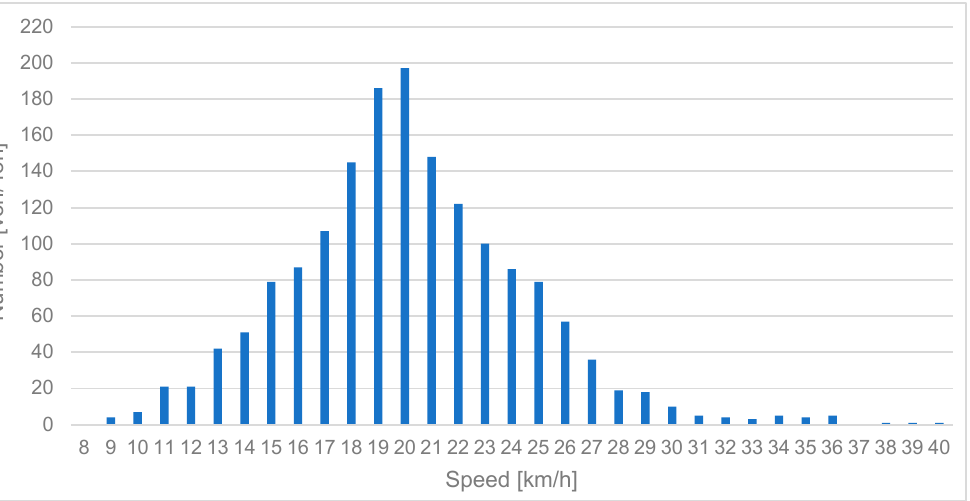
Figure 10. Comparison of the number of vehicles recorded by the microwave radar with the actual number of vehicles (the measuring station at Ś wi ę tokrzyska street) (own study).